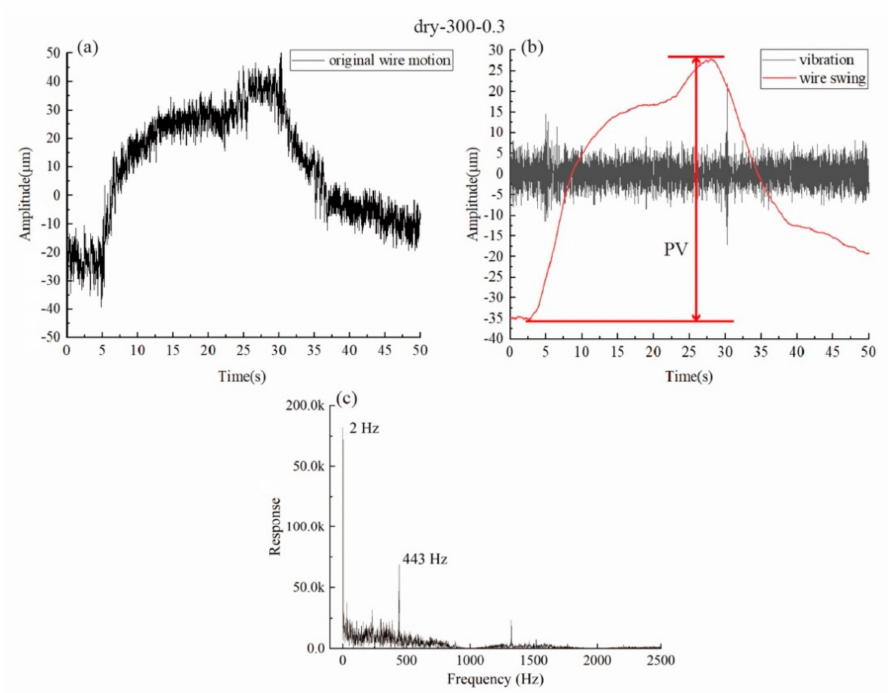
Figure 4. ( a ) The original wire motion; ( b ) the extracted vibration component and wire swing curve; ( c ) the frequency domain response for the original wire motion